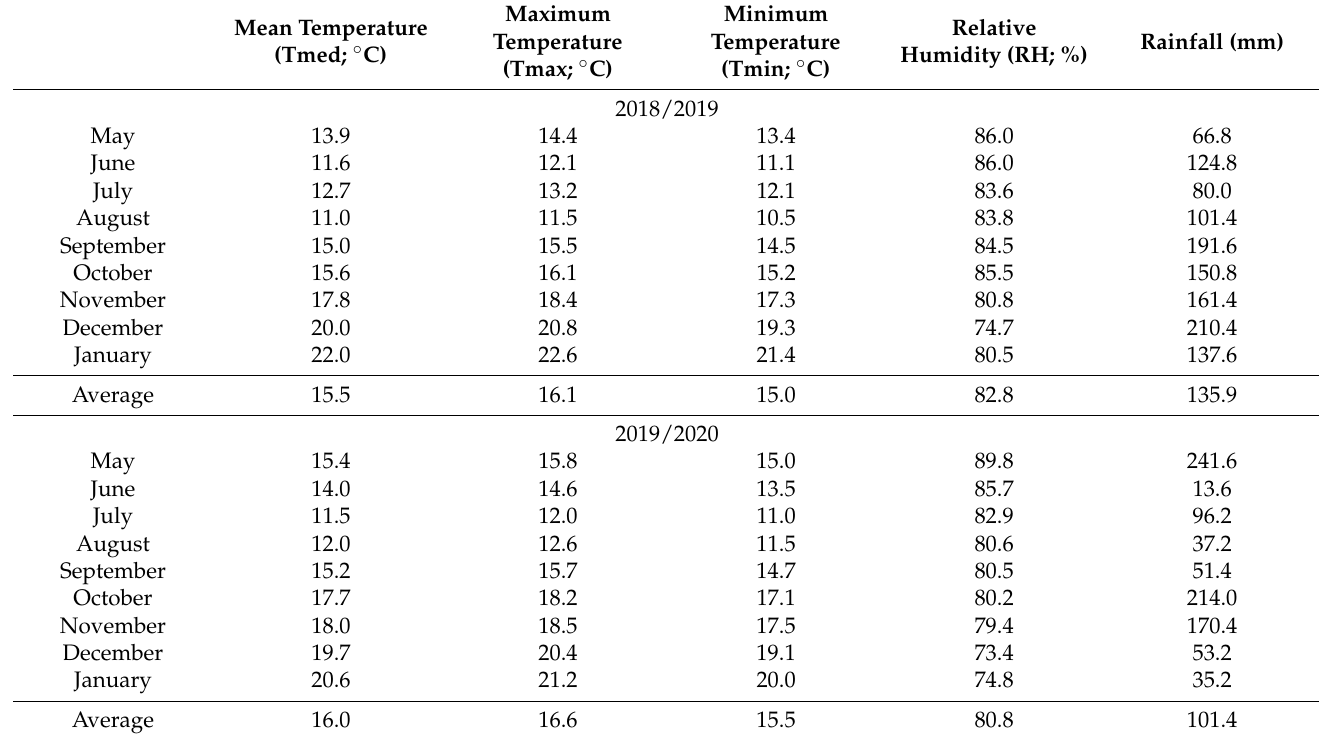
Table 1. Mean values of environmental variables measured in the 2018/2019 and 2019/2020 production cycles. Mean